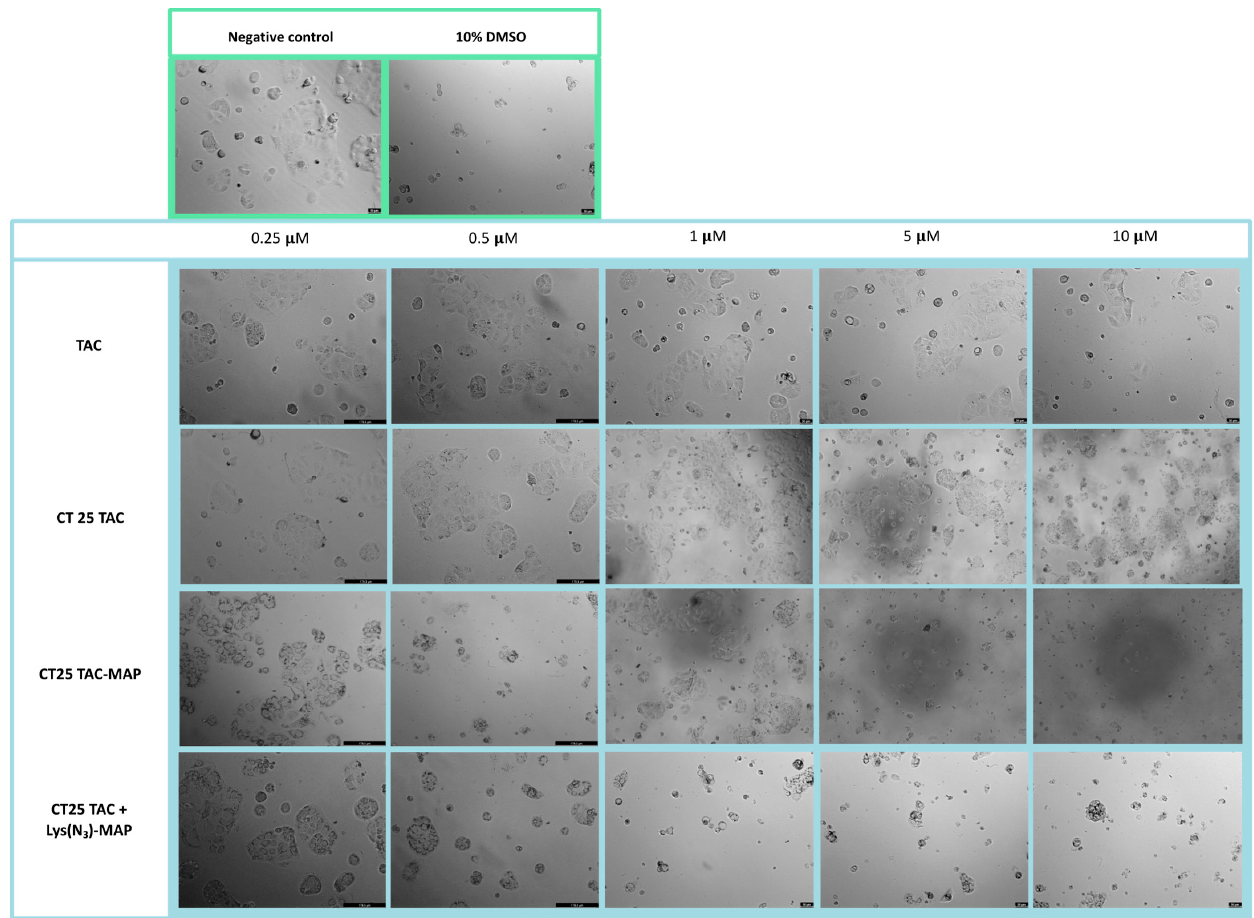
Figure 8. Microscope cellular visualization through Lionheart FX and Leica DFC350 FX of treatment with negative control (ultra ‐ purified H 2 O), positive control (10% DMSO), free drug, and NLC ‐ loaded formulations (CT25TAC, CT25TAC ‐ MAP and CT25 TAC + Lys(N 3 ) ‐ MAP) on Caco ‐ 2 cell line at concentrations of 0.25, 0.5, 1, 5, and 10 μ M.